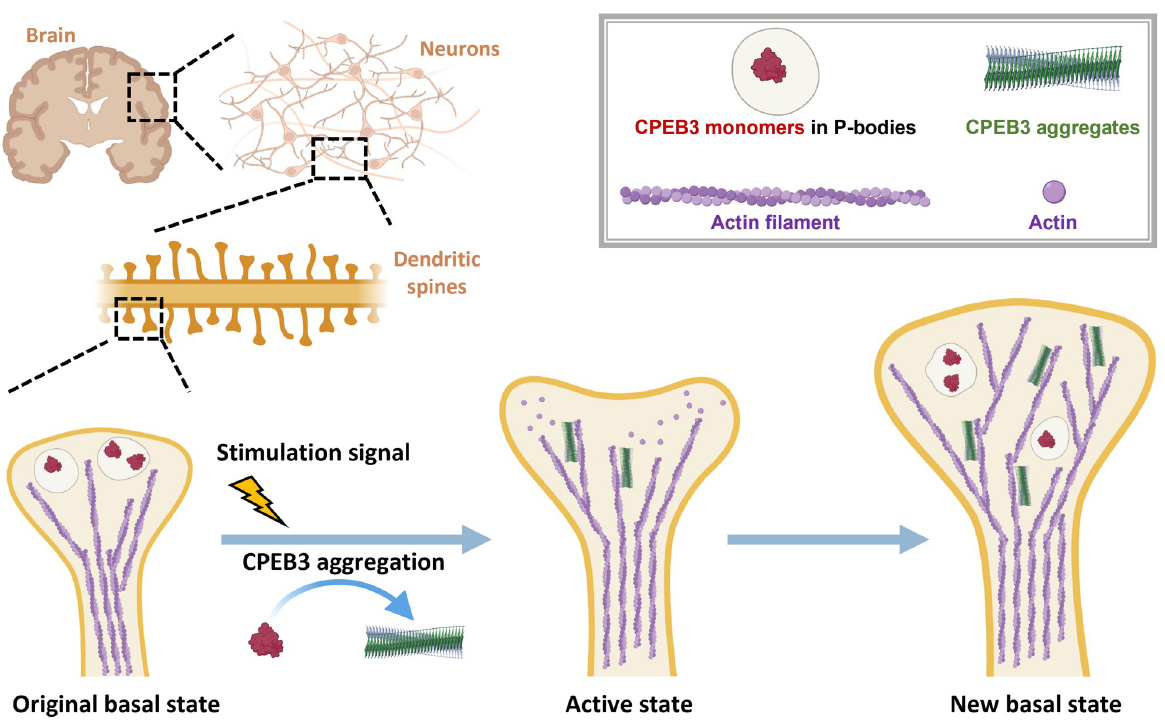
Fig 1. The conformational changes of CPEB3 provide a mechanism for the switchable translational control in dendritic spines. In a basal state, monomeric CPEB3 (shown in red) is colocalized with P-bodies and represses the translation of its target mRNAs. In response to a stimulation signal, CPEB3 monomers are released from P-bodies and then aggregate into CPEB3 fibers (shown in green). CPEB3 fibers (using the vectorial channeling mechanism) activate the local translation of synaptic proteins, including the actin proteins which are the molecular basis for the growth of the spines. The stability of the remaining prion-like CPEB3 aggregates would raise a problem of how the translational activation is turned down after a stimulation pulse. SUMO binding provides a route to return to the new basal state. A legend is shown at the upper-right corner.